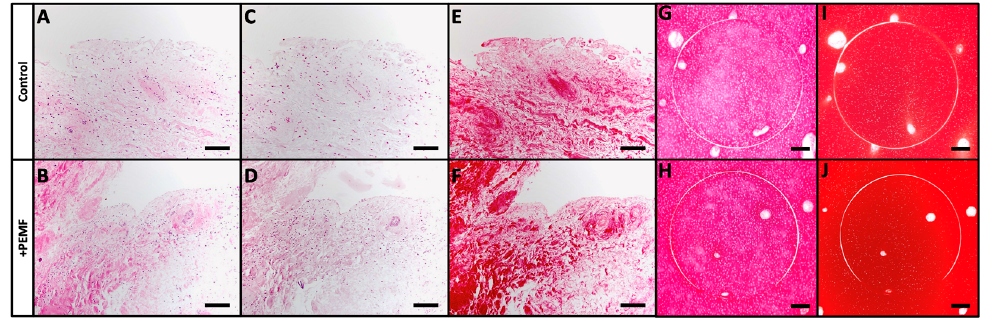
Figure 13. Histological staining of PEMF treated explants. ( A , B ) H&E, ( C , D ) Safranin O, and ( E , F ) Picrosirius Red staining of bovine synovium explants (Scale bar = 100 μ m). ( G , H ) Safranin O and ( I , J ) Picrosirius Red staining of 4 mm bovine cartilage plugs with 1 mm subcores that were reinserted into the explant forming a circular defect region (Scale bar = 400 μ m).